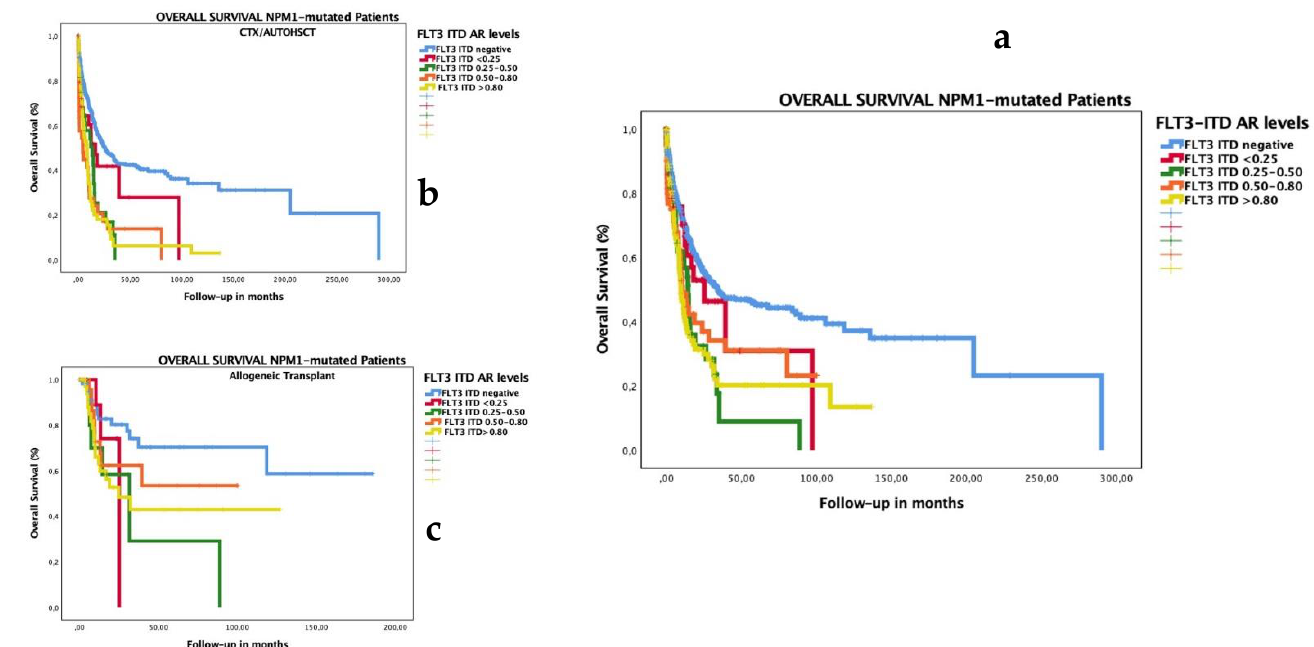
Figure 1. Impact on OS according to FLT3 – ITD AR in patients with AML co-occurring with mutated NPM1. The OS median for NPM1-mutated with FLT3 – ITD-negative group was 34.3 months (CI